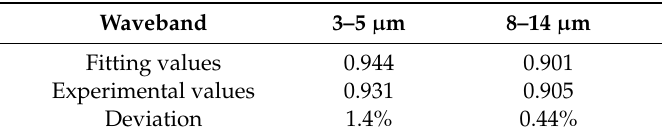
Table 8. Fitting values and experimental values.